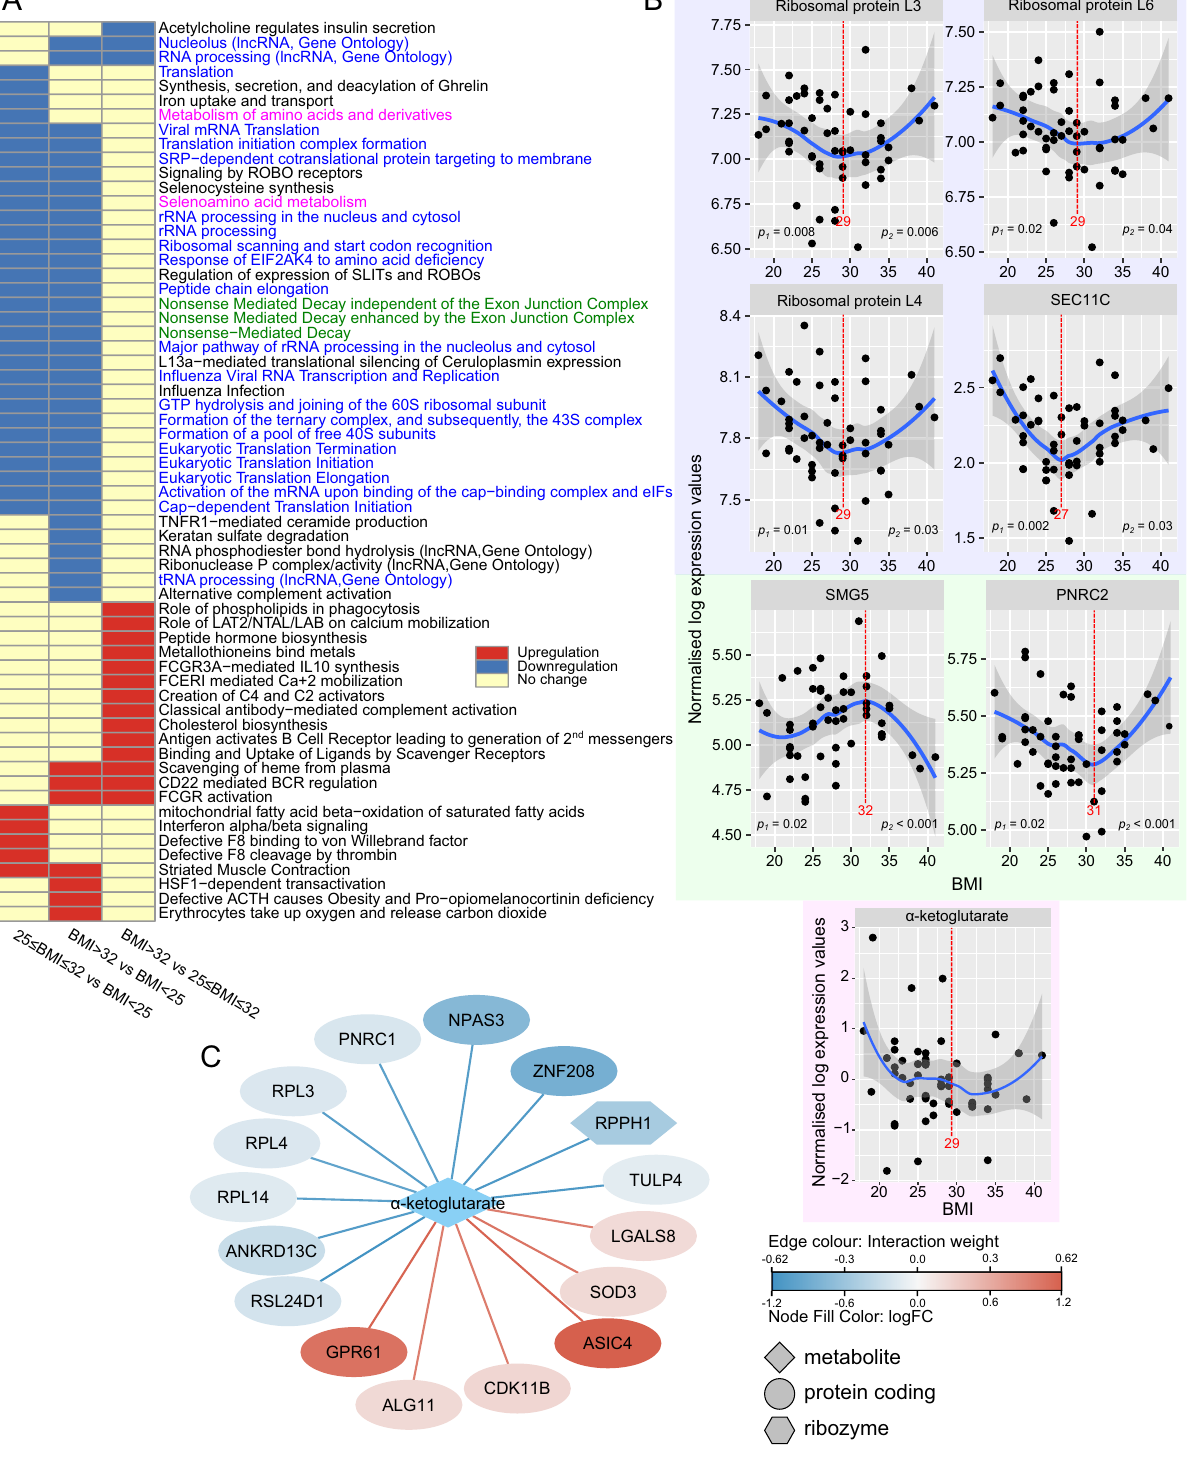
Figure 4. ( A ) Significant pathways plotted as a heatmap. Green and blue color show pathways related to translation and RNA processing. Magenta indicates amino acids metabolism pathways that include α-ketoglutarate. ( B ) Highly variable transcripts between the BMI groups with the membership in significant pathways and showing biphasic BMI relationship are plotted against BMI. α-ketoglutarate that is significantly different between the 25 ≤ BMI ≤ 32 and BMI < 25 groups was also plotted. The red line and number indicate local minimum or maximum; p1 and p2 specify regression p values before and after the local minimum/ maximum. ( C ) α-ketoglutarate—transcripts similarity network. The color of edges indicates the interaction weight and node color indicates log fold change in the 25 ≤ BMI ≤ 32 vs BMI < 25 comparison. Node shape indicates transcripts’